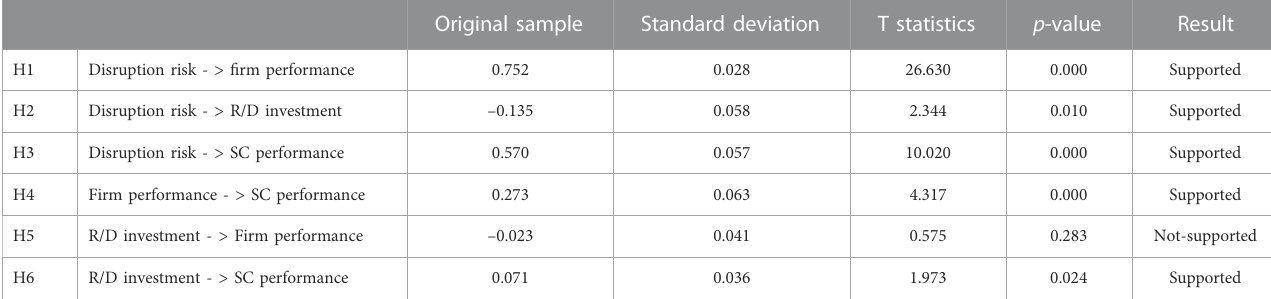
TABLE 4 Direct effect between independent variables and dependent variables with t-values and beta coef fi cients.